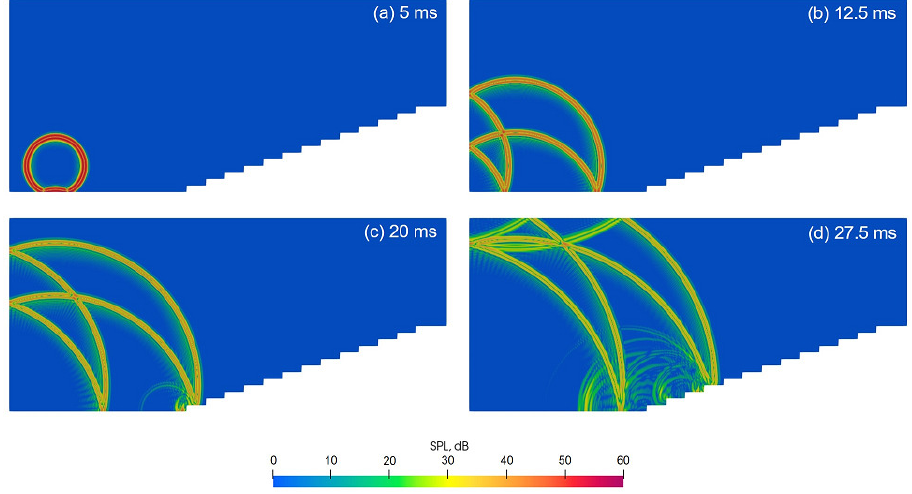
Figure 12. Visualized zx plane ( y = 0) sound fields at ( a ) 5 ms, ( b ) 12.5 ms, ( c ) 20 ms, and ( d ) 27.5 ms.